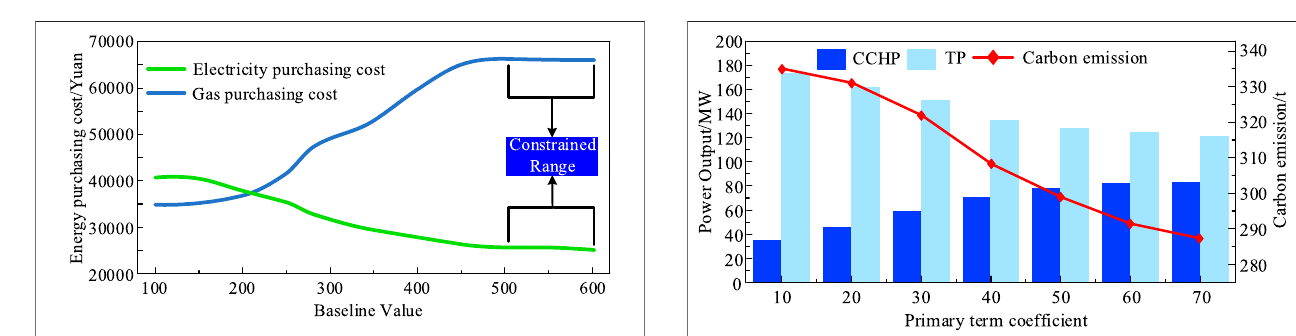
FIGURE 10 | Impact of the primary term coef fi cient b on the carbon emissions and the output of CCHP and